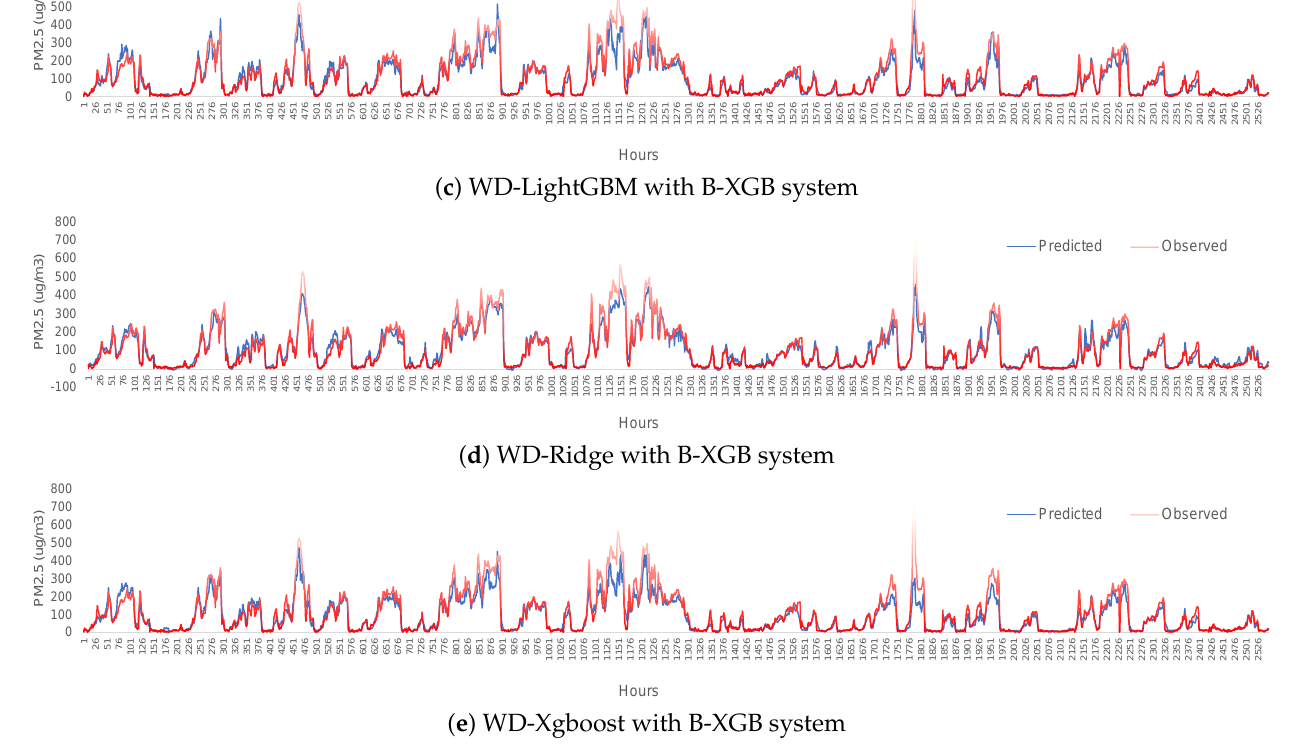
Figure 24. Comparison of the observed trend with the predicted time series (test results) of all